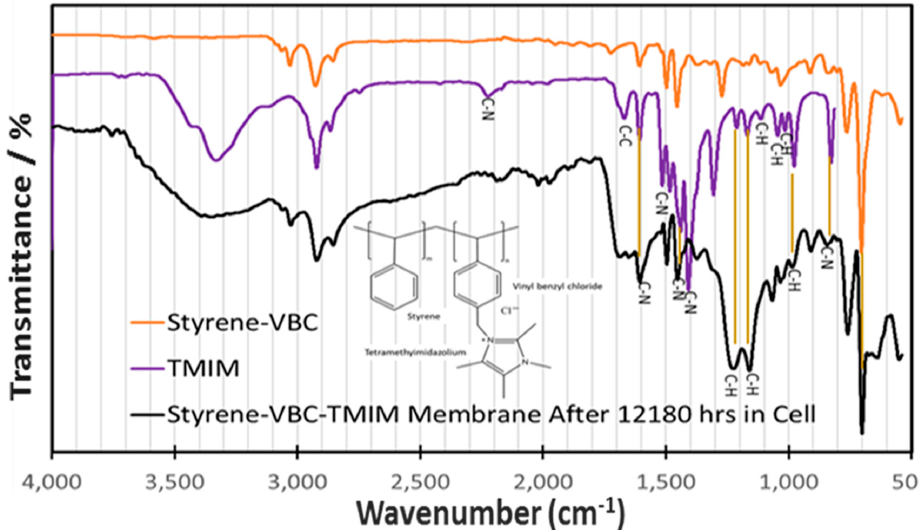
Figure 2. Infrared spectrum of (top) the styrene-vinyl benzyl chloride (VBC) copolymer that is used for membrane synthesis; (middle) tetramethyl imidazole (TMIM), the other component used in the membrane synthesis; (bottom) the active area of the ePTFE supported Sustainion ® X37-T membrane. The spectrum was taken after removing the membrane from the alkaline exchange membrane (AEM) water electrolyzer after operating at 60 °C in 1 M KOH for 12,180 h, and carefully cleaning the membrane for the FTIR tests.